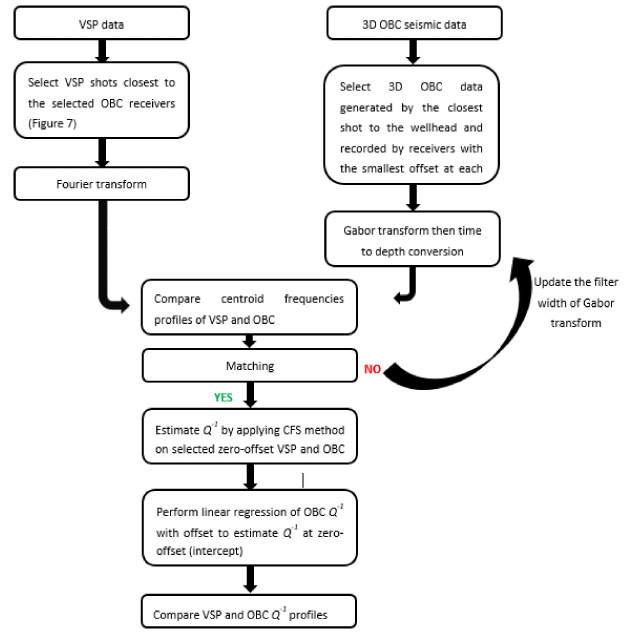
Figure 6. The proposed workflow to estimate the filter width of Gabor transform and to validate Q − 1 profile at the well